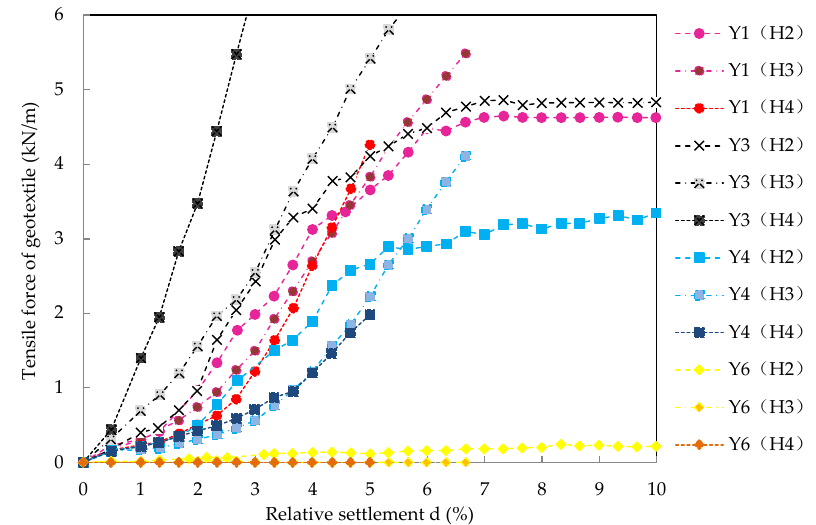
Figure 7. Effect of the subsidence width on the tensile force of the geotextile.